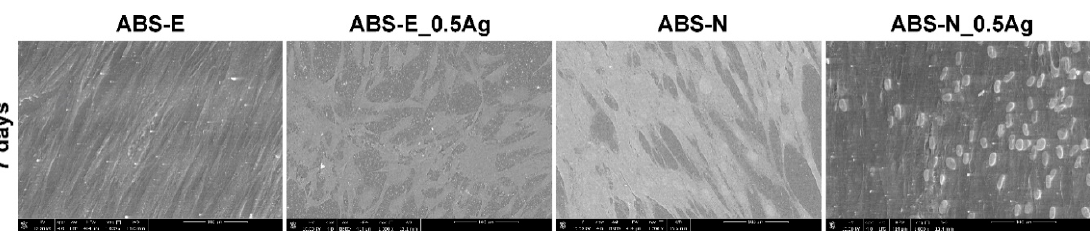
Figure 11. SEM images of Hs680.Tr cells in direct contact with the tested materials. Magnification 1000 × .